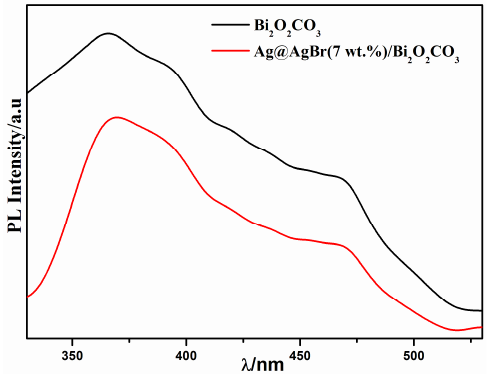
Figure 6. Photoluminescence (PL) spectra of pure Bi 2 O 2 CO 3 and Ag@AgBr(7 wt %)/Bi 2 O 2 CO 3 sample (excitation at 280 nm at room temperature).